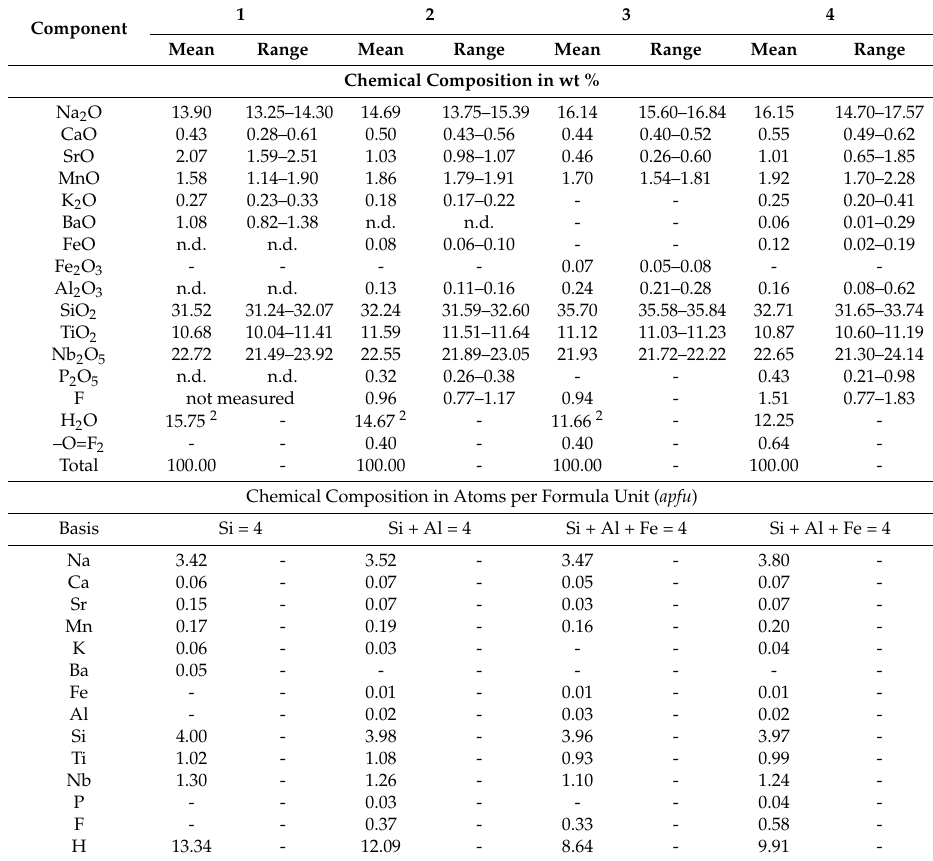
Table 1. Chemical composition of shkatulkalite